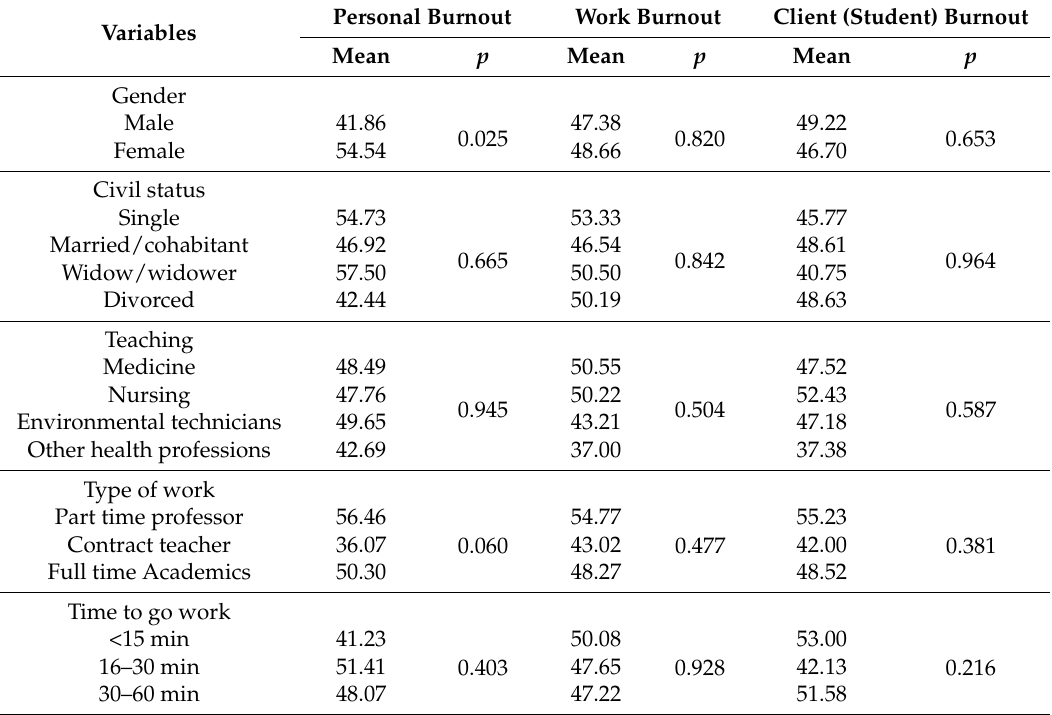
Table 3. Univariate analysis for the three dimensions of the Copenhagen Burnout Inventory.